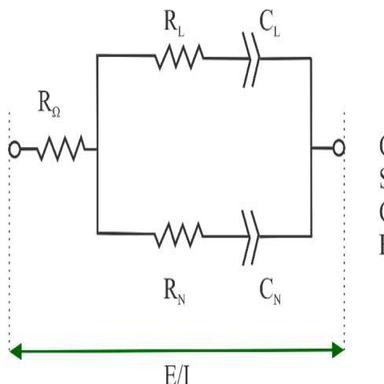
The equivalent circuit representing the generic electrochemical model proposed in this work and the different perturbation functions used in the electrochemical techniques.